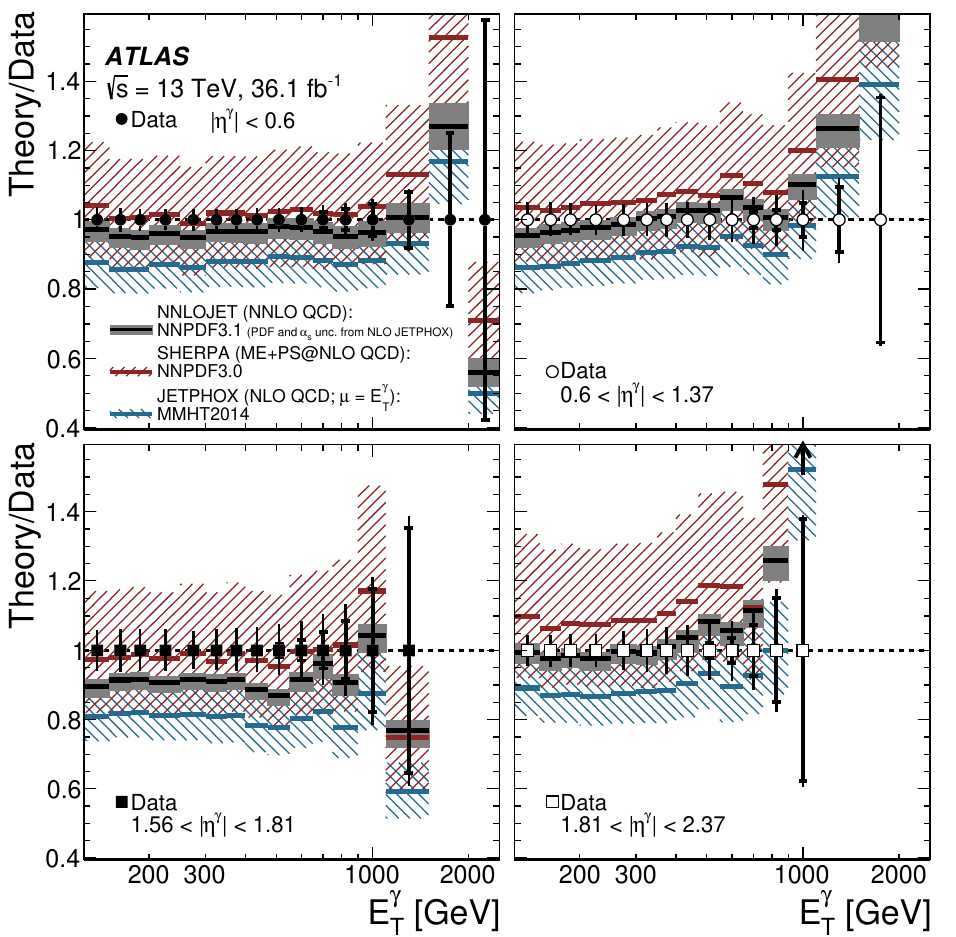
Figure 12 . The ratio of the NLO pQCD prediction of Jetphox with (cid:22) R = (cid:22) F = (cid:22) f = E (cid:13) ratio of the ME+PS@NLO QCD prediction of Sherpa 2.2.2 and the ratio of the NNLO QCD prediction of Nnlojet to the measured di(cid:11)erential cross section for isolated-photon production as a function of E (cid:13) in di(cid:11)erent regions of j (cid:17) (cid:13) j . The symbols for the data are centred at unity T and the inner (outer) error bars represent the relative data statistical uncertainties (statistical and systematic uncertainties added in quadrature). The bands represent the theoretical uncertainty; in the case of Nnlojet , the uncertainties due to the PDFs and (cid:11) s are estimated at NLO with Jetphox